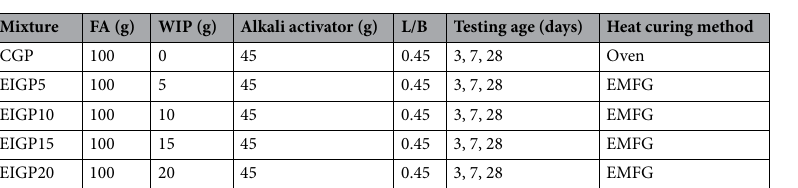
Table 2. Mix proportions of GP